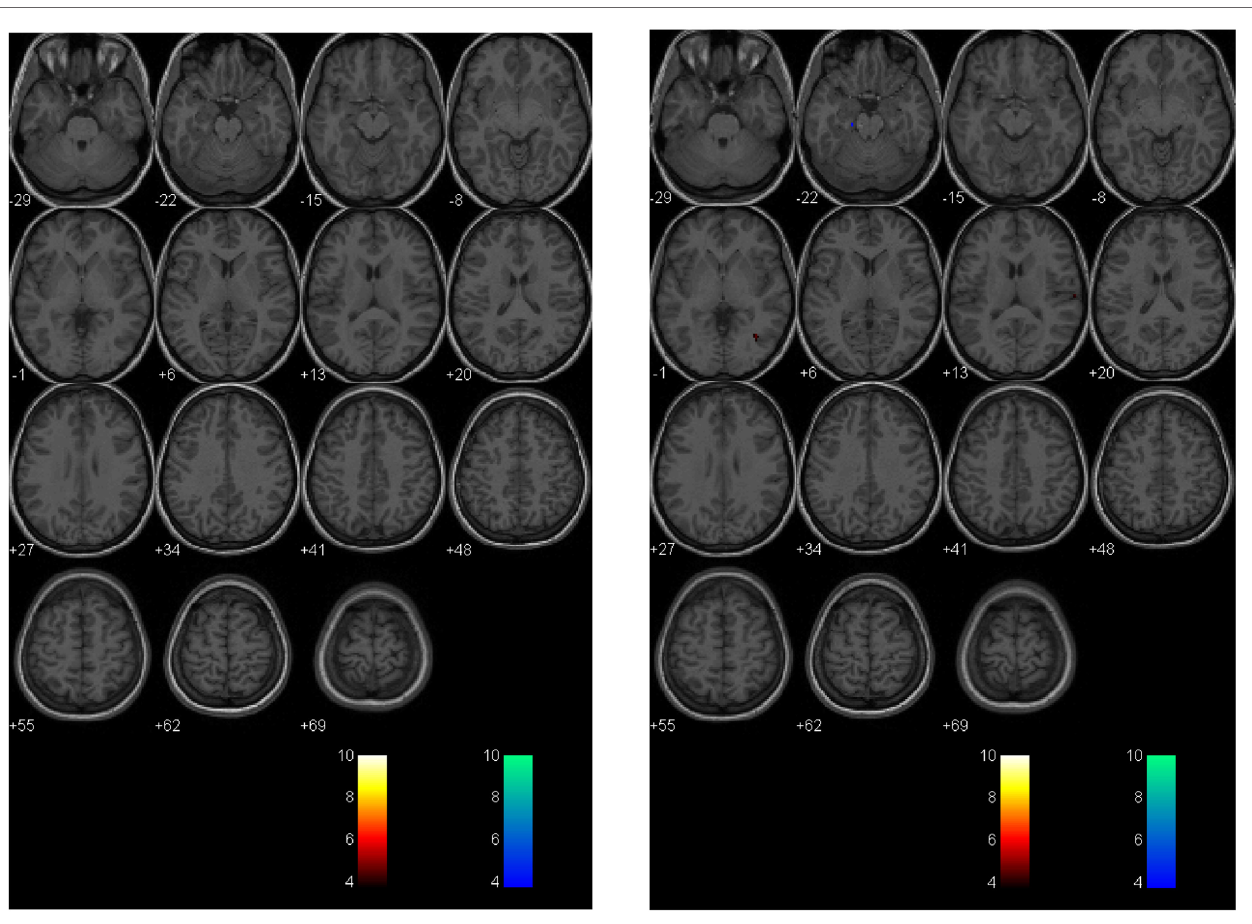
FiGUre 5 | Longitudinal assessment of healthy control subject . Second-level analysis in a healthy adolescent imaged 18 months apart and compared to a normal atlas reveals stable CVR assessment. The p -value is 0.005 as in Figure 4